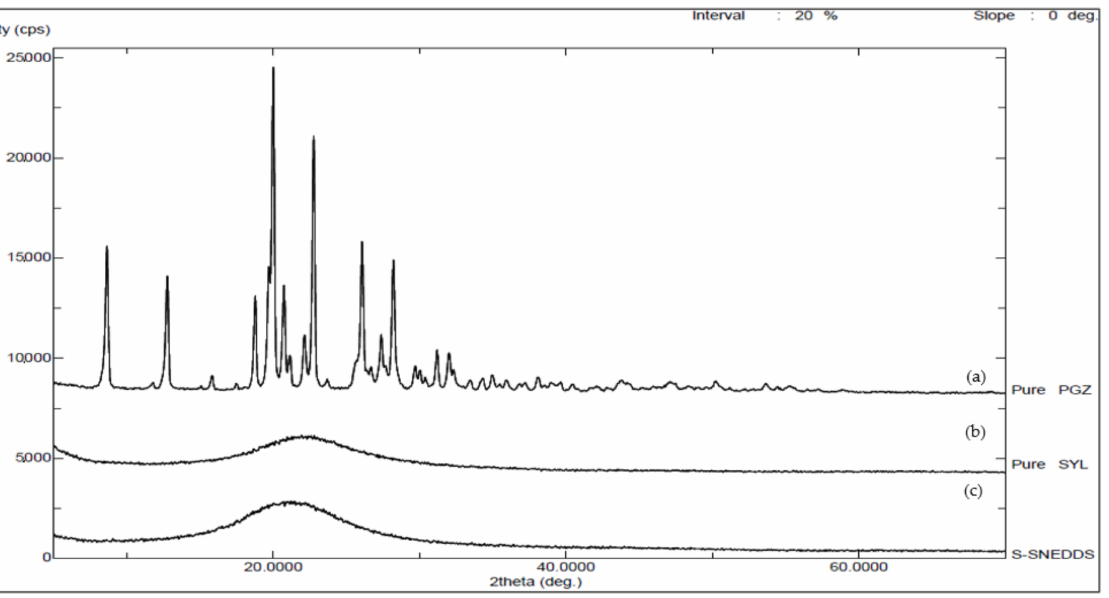
Figure 5. XRPD thermograms of (a) pure PGZ, (b) pure SYL and (c) PGZ loaded S-SNEDDS. Abbrevi- ations: XRPD; X-ray powder diffraction; SYL, Syloid; S-SNEDDS, solidified self-nanoemulsifying drug delivery system; PGZ, Pioglitazone